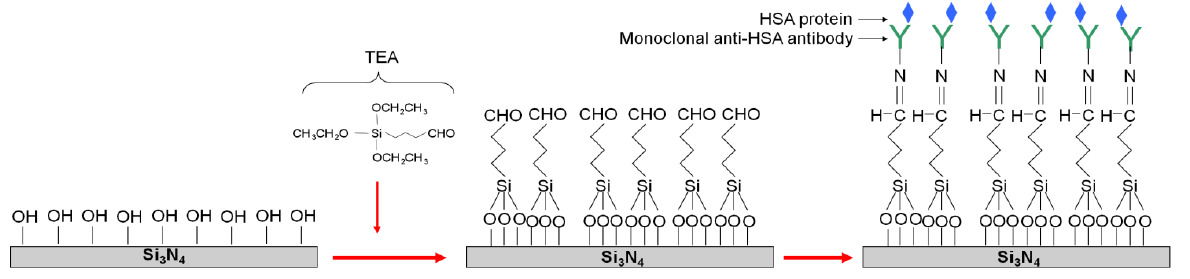
Figure 2. Scheme of the silicon nitride surface functionalization of the direct immobilization of anti-HSA